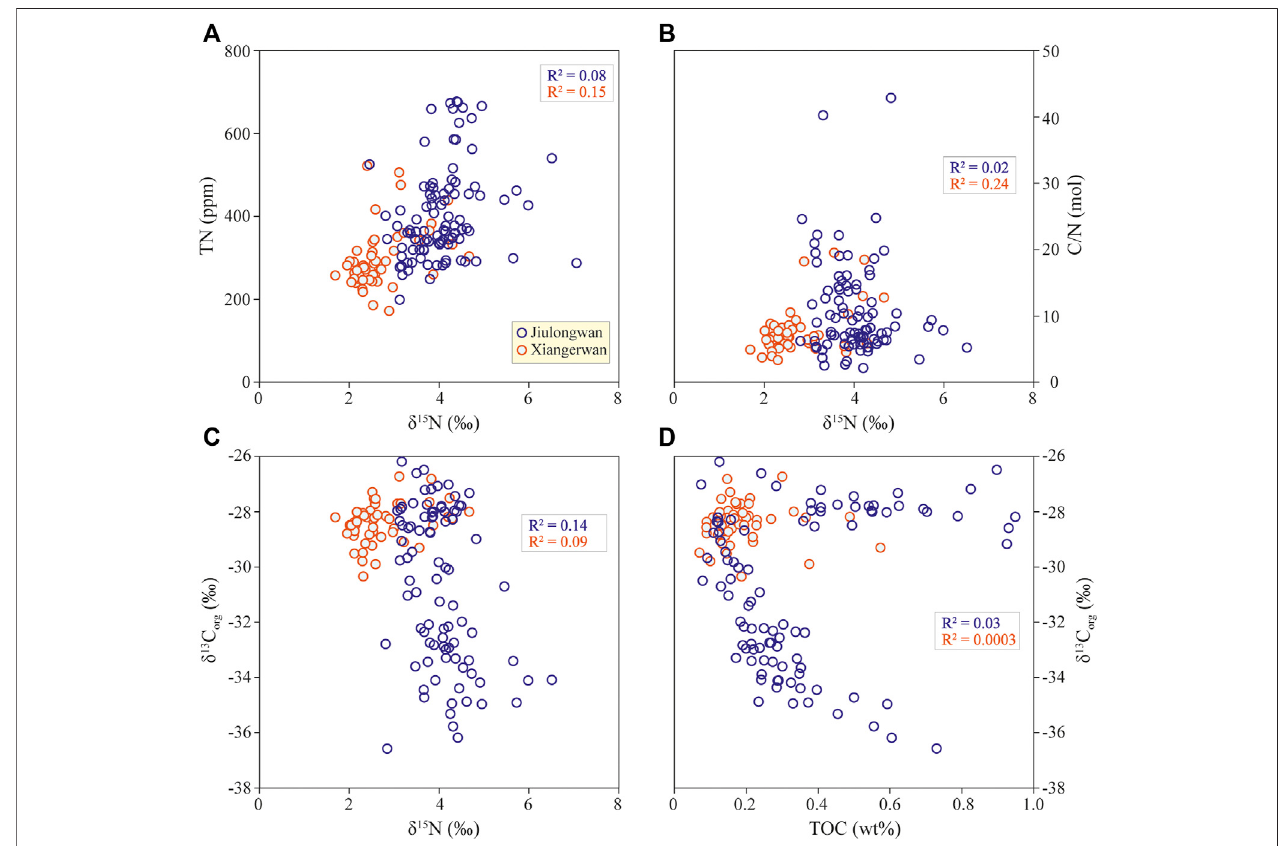
FIGURE 4 | Cross plots of TN vs. δ 15 N (A) , C/N vs. δ 15 N (B) , δ 13 C org vs. δ 15 N (C) , and δ 13 C org vs. TOC (D) in study sections.